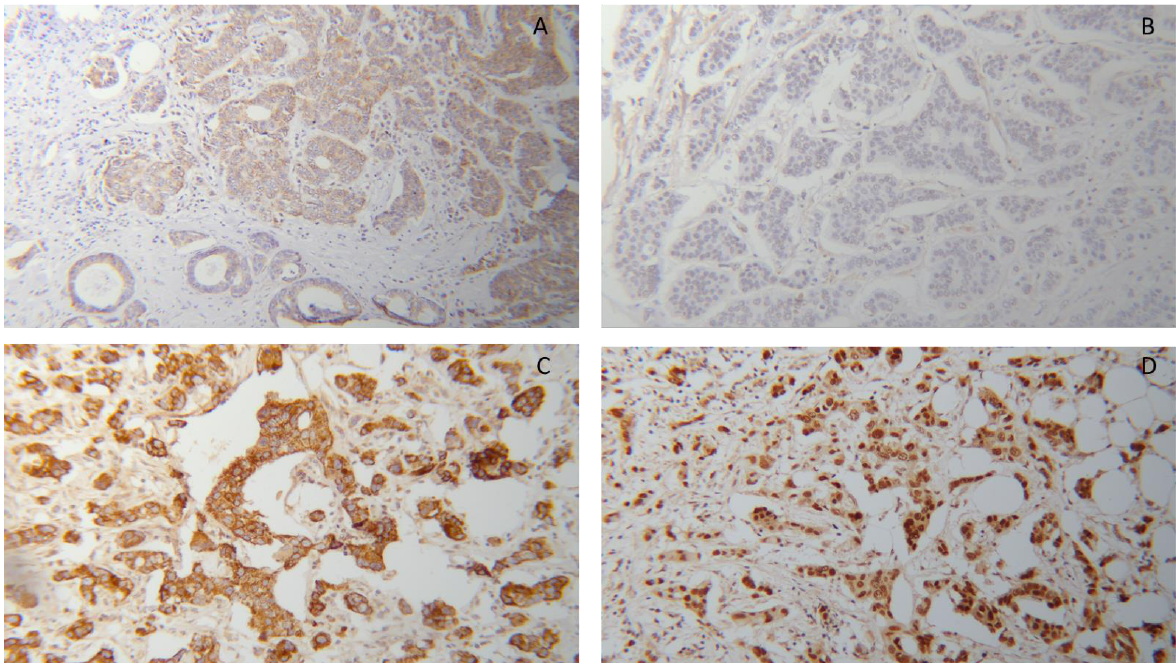
Figure 1. Immunohistochemical detection of PPAR γ ( A , C ) and RXR α ( B , D ) in breast cancer tissues from two patients showing weak ( A , B ) or strong ( C , D ) expression of PPAR γ and RXR α in the same tumor, respectively; all pictures 10× lens.